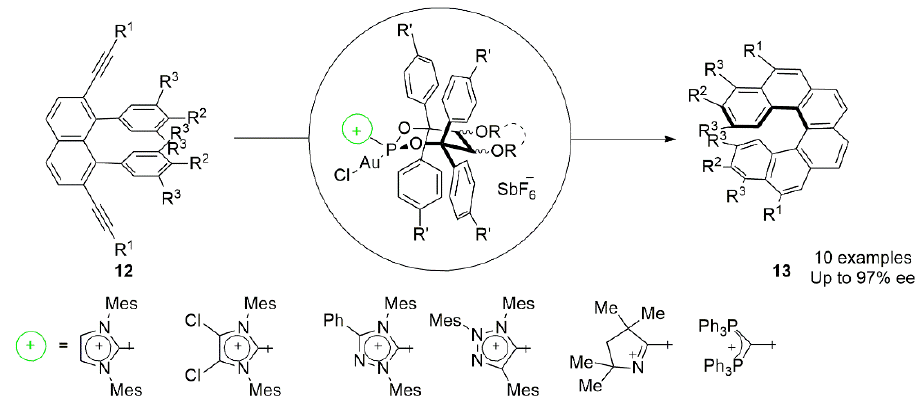
Figure 7. Gold-catalyzed intramolecular hydroarylation reaction of suitable diynes ( 12 ) by using cationic phosphonite ligands.